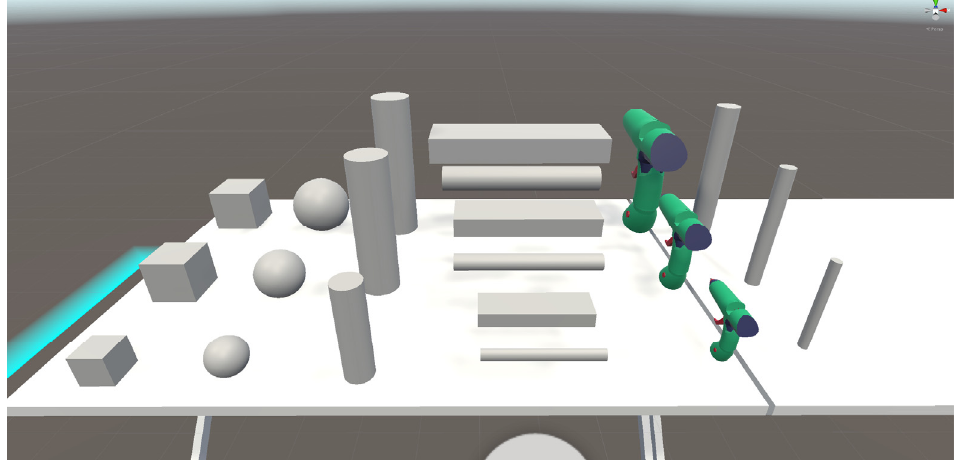
Figure 6. Training scene with the objects for the machine learning algorithms. Three dice, thee balls, three horizontal cylindric objects, three vertical cylindric objects, three cuboids, and three drilling machines, as well as three smaller horizontal cylindric objects.